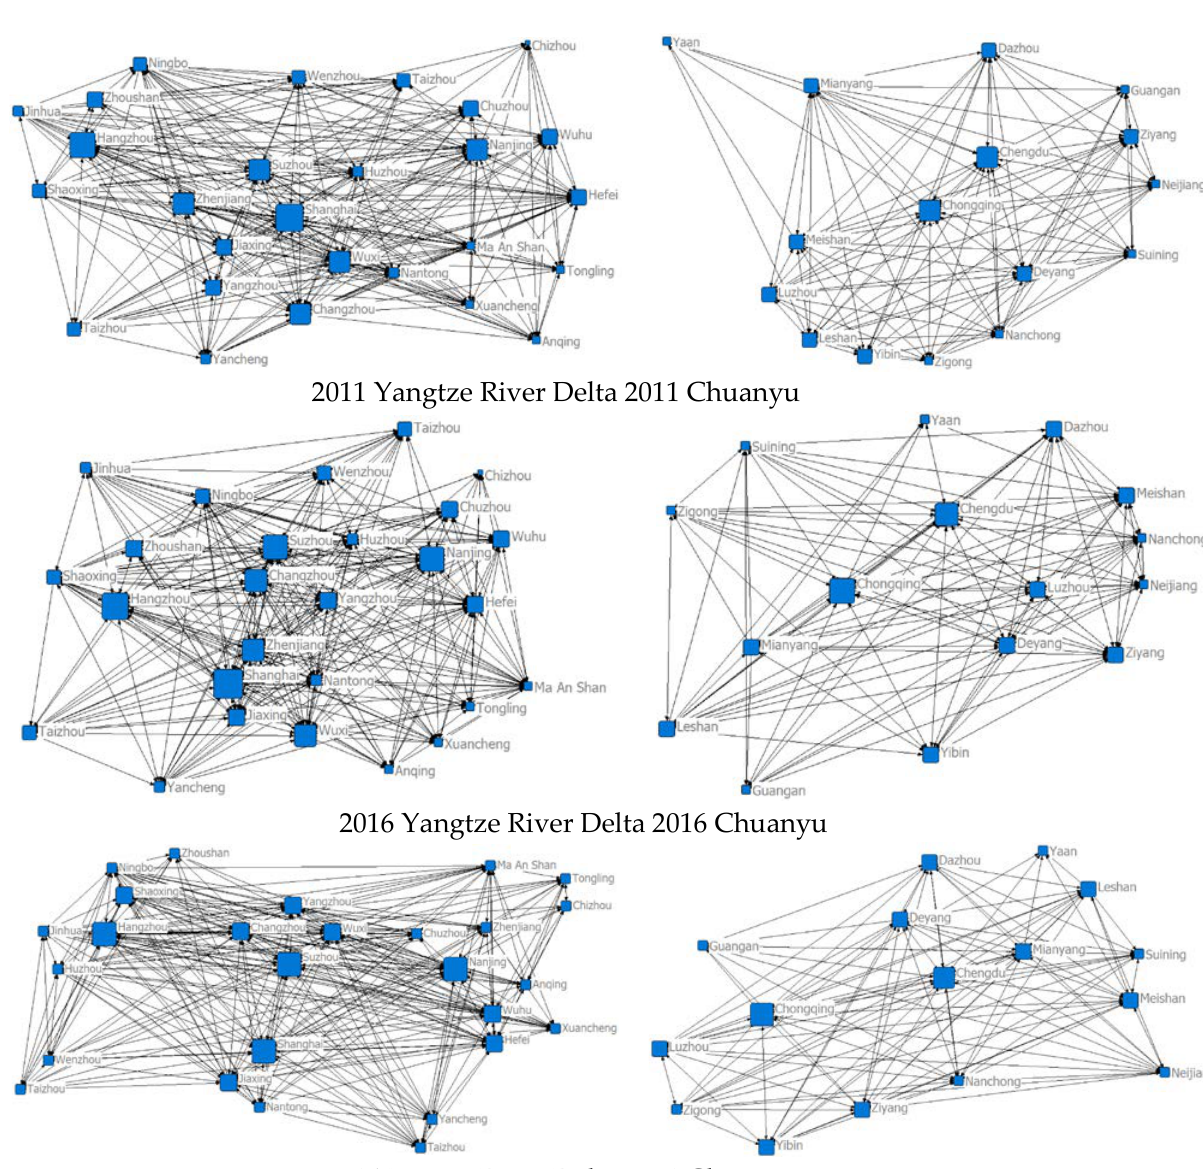
Figure 4. Visualization diagram of economic network structure.